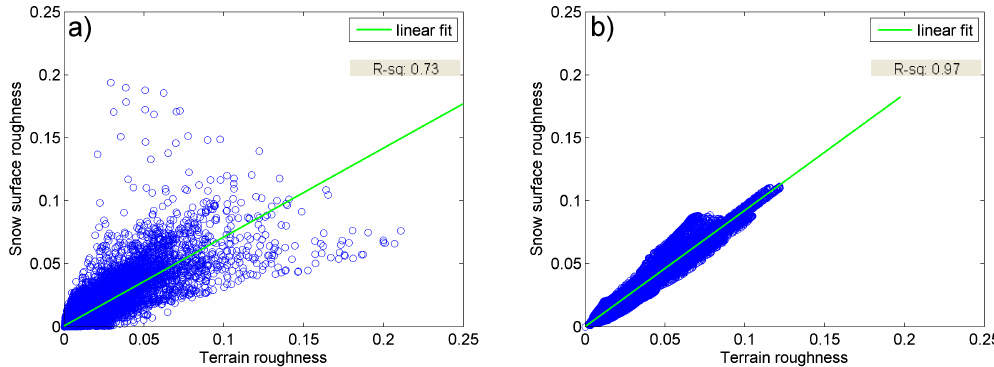
Fig. 7: Snow surface roughness as a function of terrain roughness for every pixel in CB1 in the year 2011 for scales of (a) 5 m and (b) 25 m. In green the linear regression line.